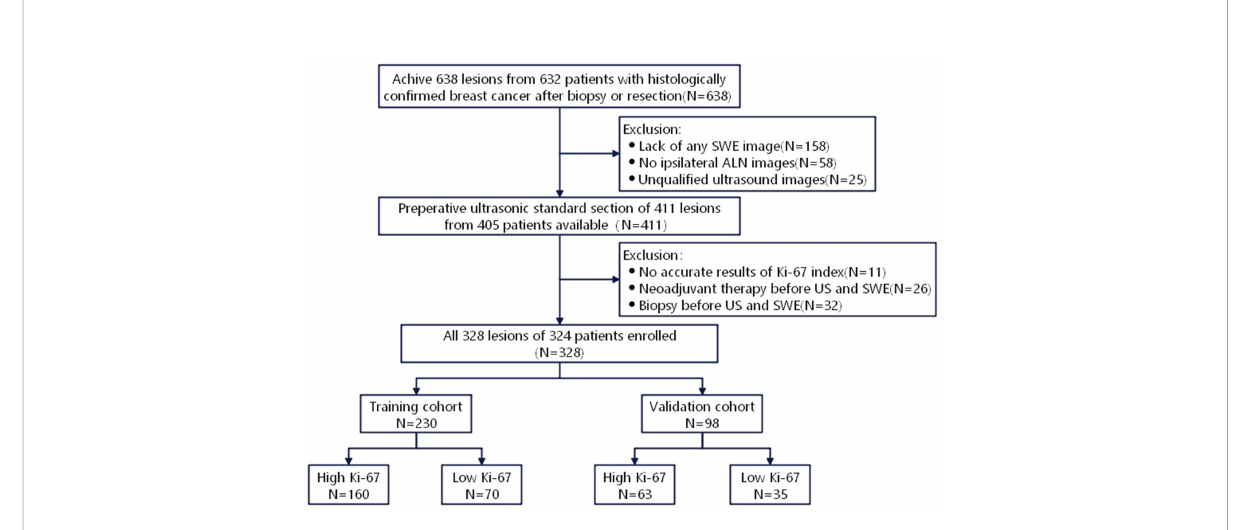
FIGURE 1 Recruitment pathway for BC patients